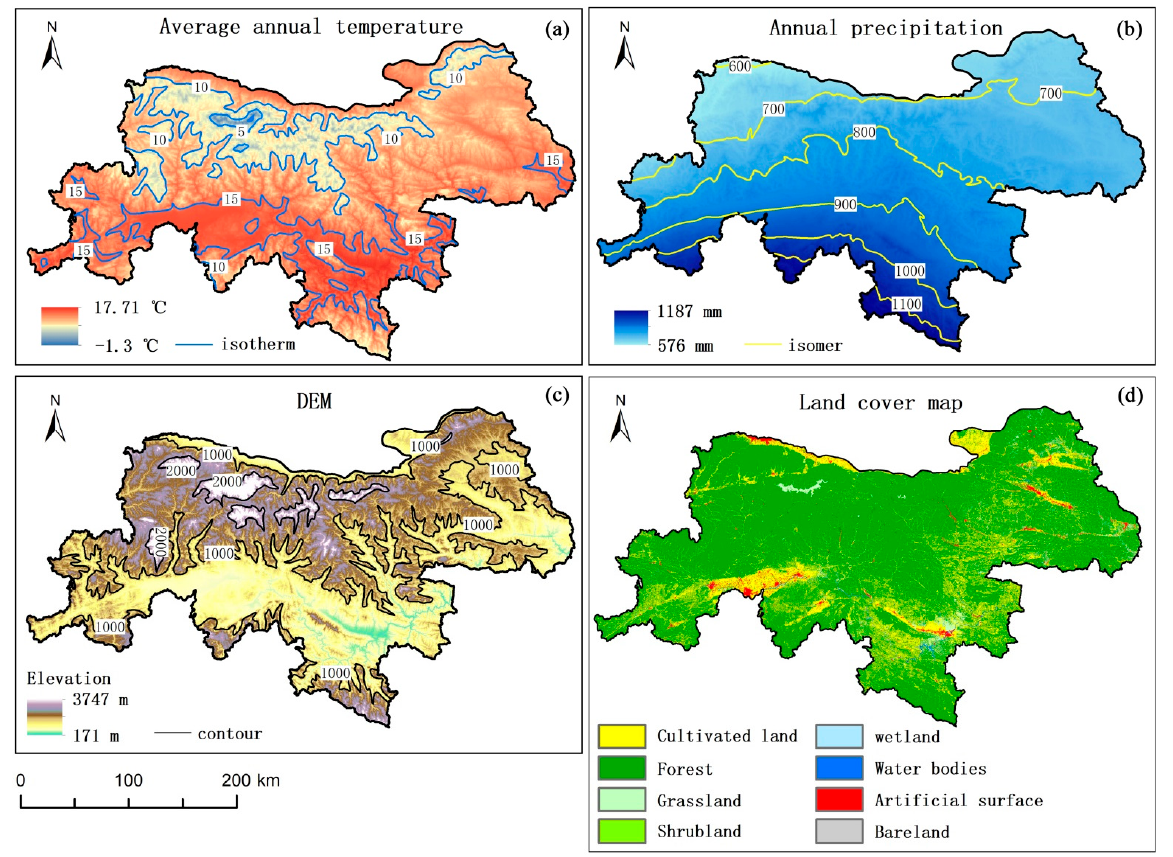
Figure 2. Characteristics of the study area. ( a ) Average annual temperature in 2018, ( b ) total annual precipitation in 2018, ( c ) digital elevation model (DEM), and ( d ) land cover classes in 2020. The land cover map is derived from the GlobeLand30 land cover dataset (http://www.globallandcover.com/ (accessed on 15 July 2022)).